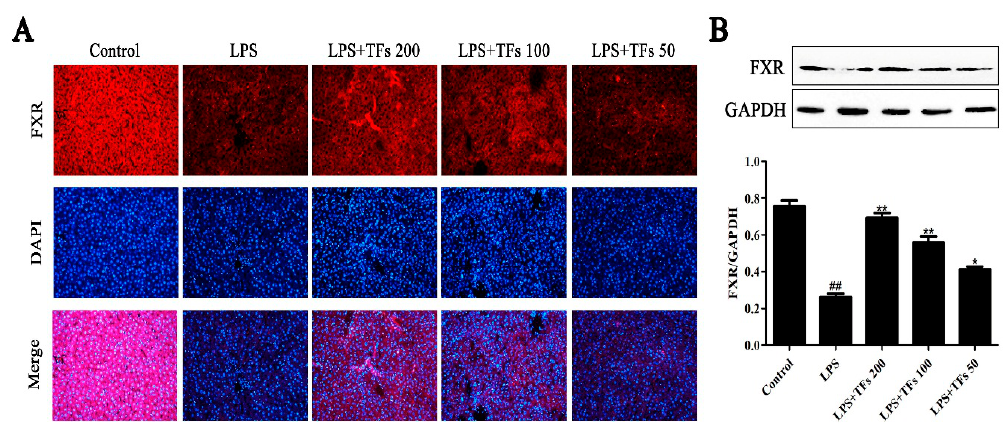
Figure 3. TFs activated the FXR signal pathway. ( A ) Effects of TFs on the expression level of FXR on the basis of the immunofluorescence assay (200× magnification). ( B ) Effects of TFs on the expression level of FXR in liver tissue on the basis of the western blotting assay. The values are expressed as the mean ± SD ( n = 3); ## p < 0.01 versus control group; * p < 0.05and ** p < 0.01 versus model group. DAPI: